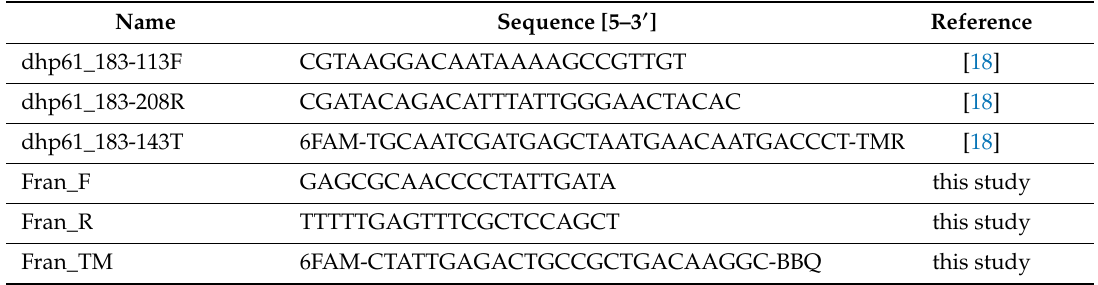
Table 2. Primers and probes used for qPCR